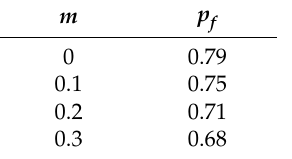
Table 1. Dependence of the value of pressure at the end of loading on the value of m introduced in